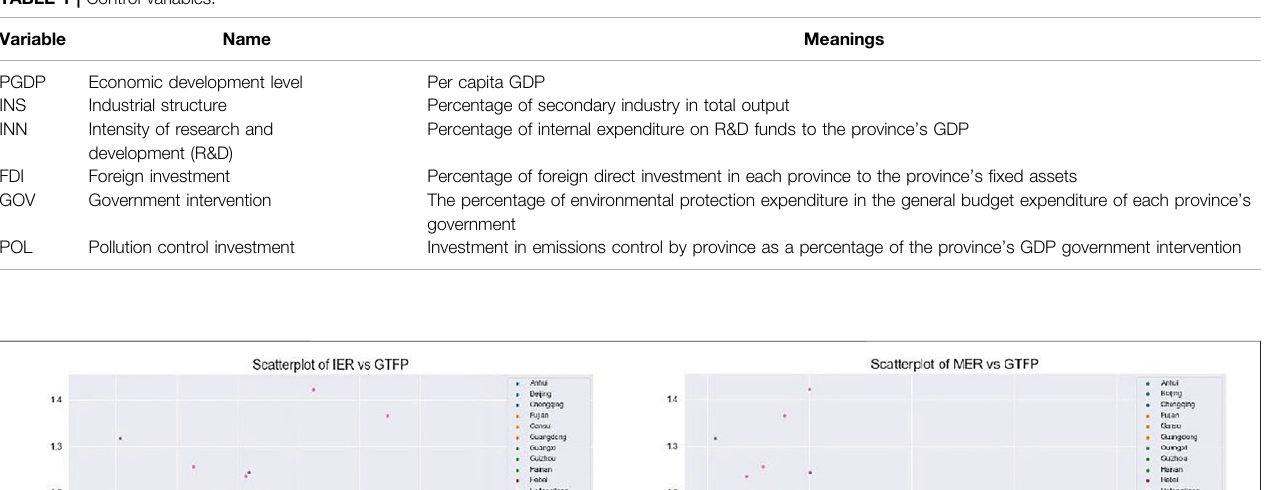
TABLE 1 | Control variables.